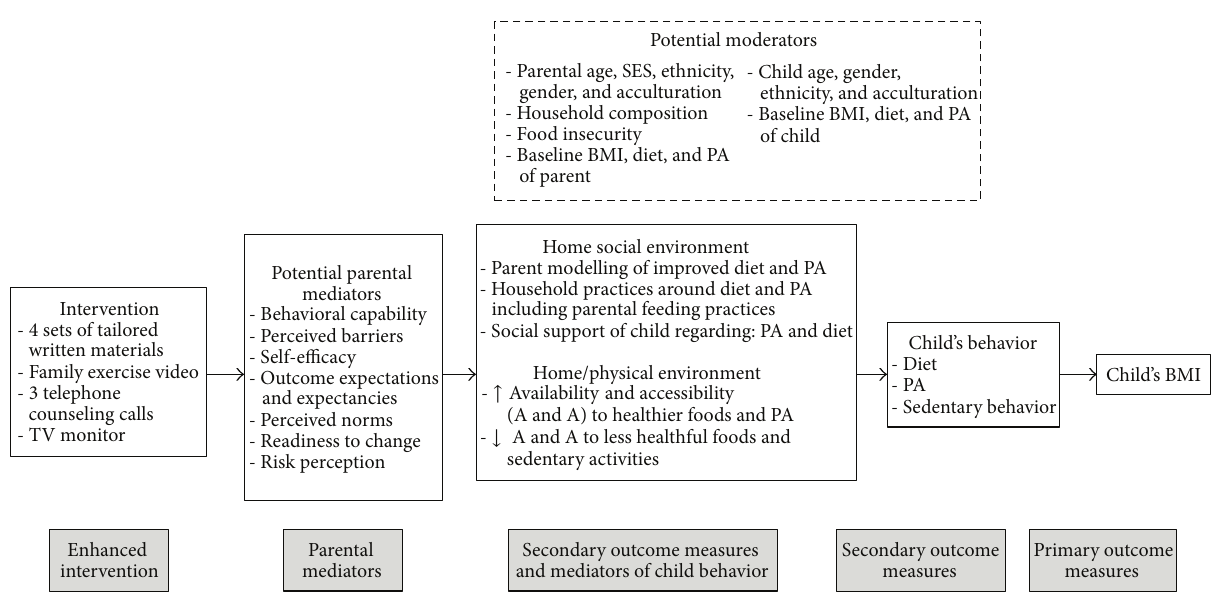
Figure 1: Healthy homes, healthy families intervention logic